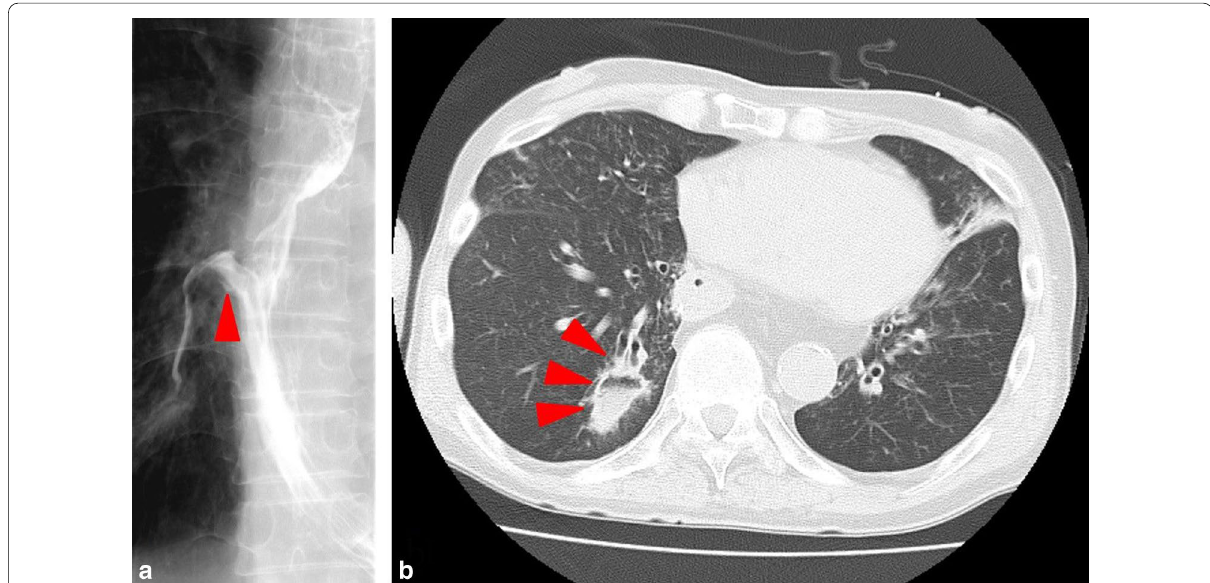
Fig. 2 Imaging examinations performed after the conservative treatment. a A Gastrografin esophagram showed that the leakage was localized (red arrowhead). b CT showed an abscess as a reduction in permeability localized in the right lung (red